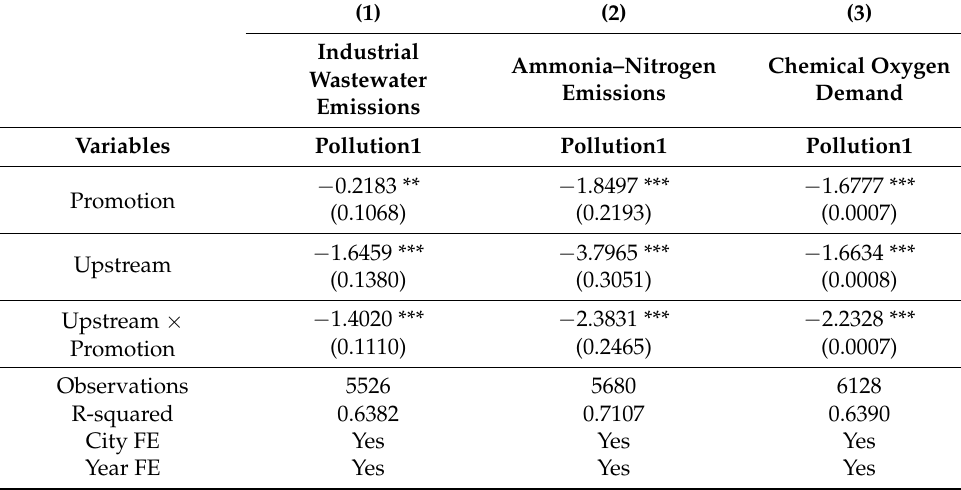
Table 6. Effect of officials’ promotion on pollution emissions.